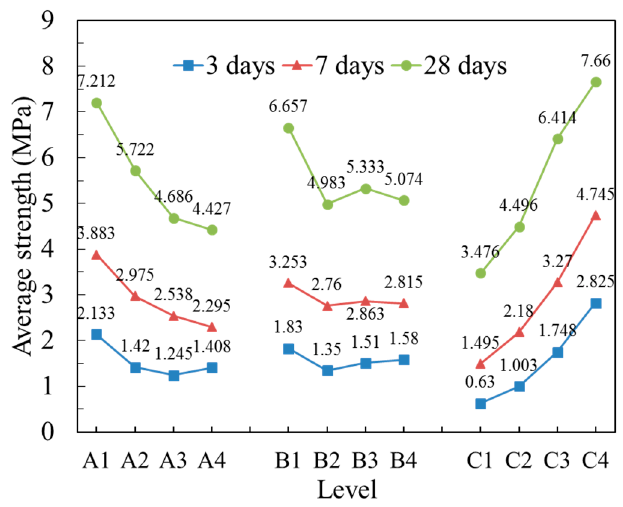
Figure 6. The average compressive strength (curing age: 3 days, 7 days and 28 days) of the backfill body at each level.